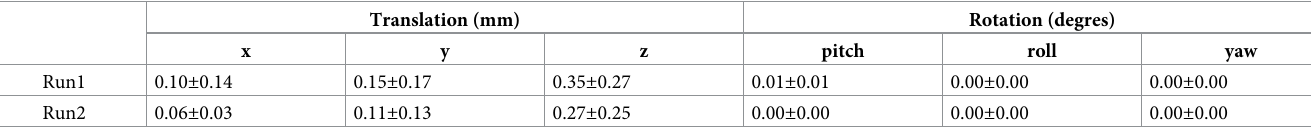
Table 1. Average framewise displacement during the functional